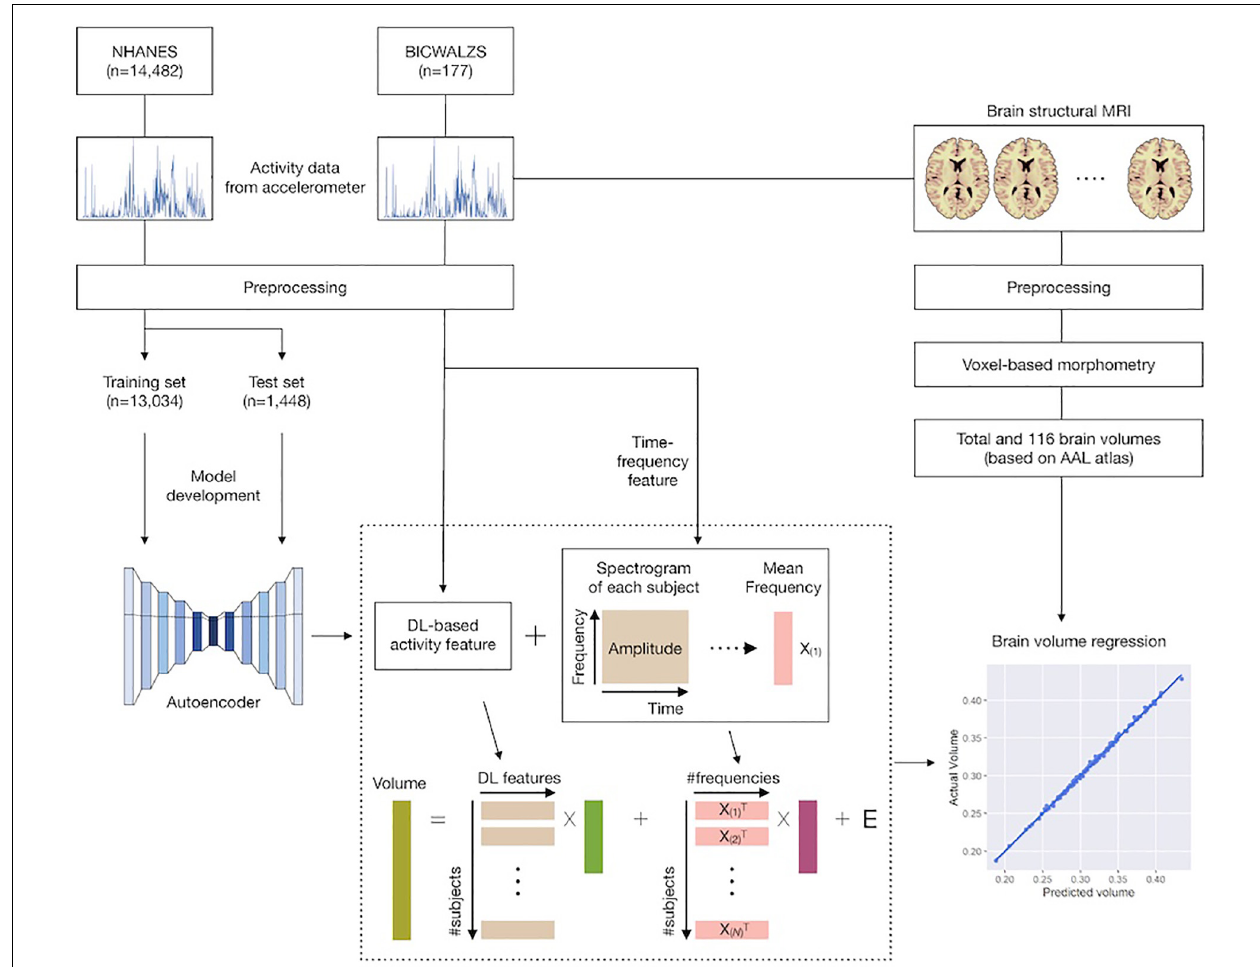
FIGURE 1 | Schematic overview of the study. Accelerometer data from the NHANES and BICWALZS were collected and preprocessed. Using an unsupervised deep learning approach, the feature extraction model was developed using the activity data in the NHANES dataset; subsequently, activity features were extracted from the BICWALZS activity dataset using the developed feature extraction model together with the time-frequency domain feature extraction model. Finally, linear regression models that estimated the volumes of 116 regions based on the extracted activity features were constructed. NHANES, National Health and Nutrition Examination Survey dataset; BICWALZS, Biobank Innovations for chronic Cerebrovascular disease With ALZheimer’s disease Study; MRI, magnetic resonance imaging; AAL, automated anatomical